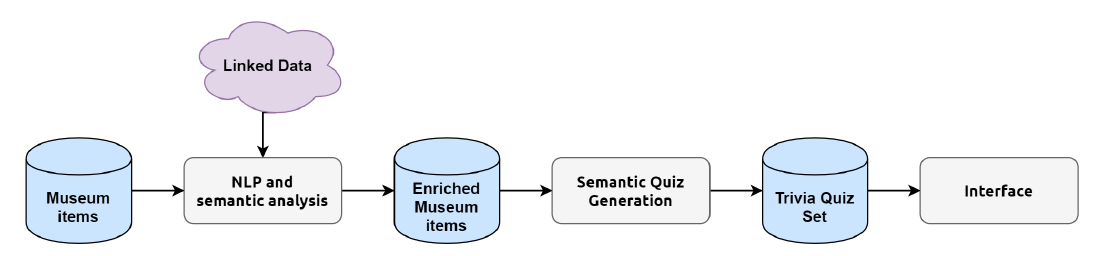
Figure 1. Methodology for the creation of the Trivia Quiz